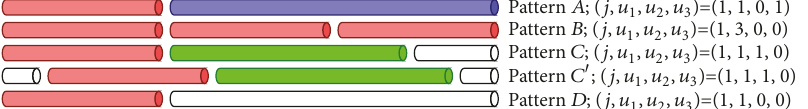
Figure 1: Some feasible patterns for cutting 2-, 3-, and 4-meter pipes from single-size, 6-meter